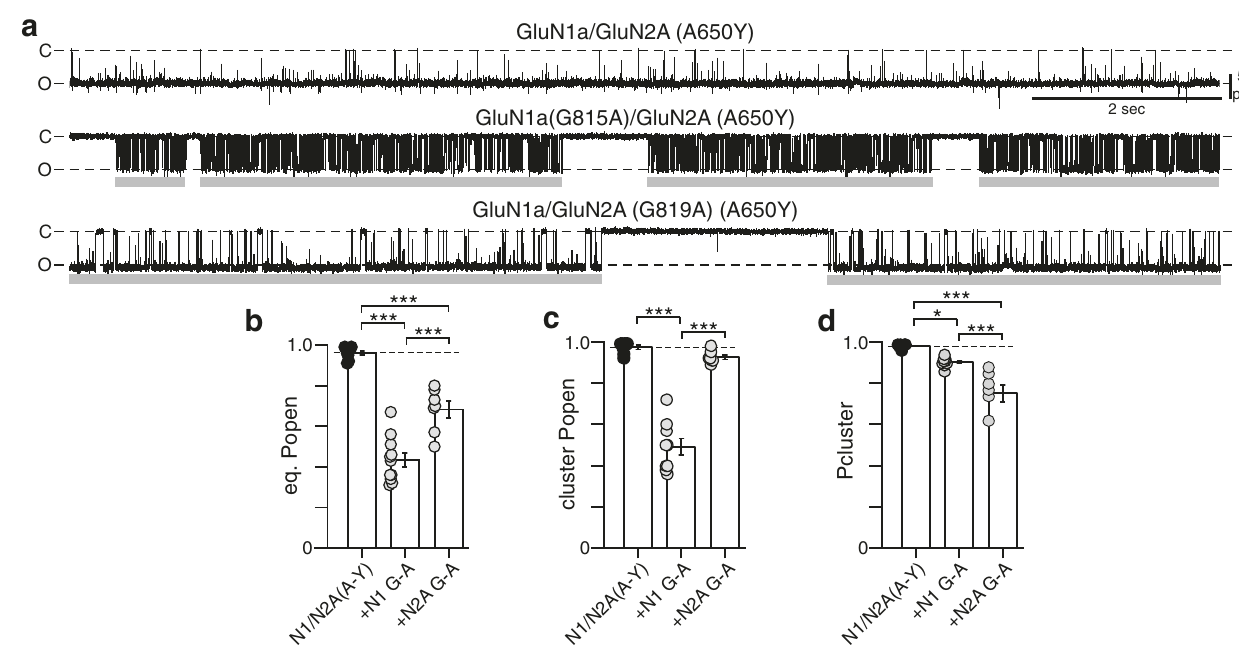
Fig. 4 | Prying open the M3 gate. a On-cell recordings of constructs containing a tyrosine (Y) substituted at A650 in GluN2A, either alone or with G-to-As at the conserved glycines. Records displayed and analyzed as in Fig. 2. b – d Bar graphs (mean±SEM) forsingle channel equilibrium P open ( b ),clusterP open ( c ),and cluster probability (P cluster ) ( d ). *p <0.05, *** p <0.001, one-way ANOVA with